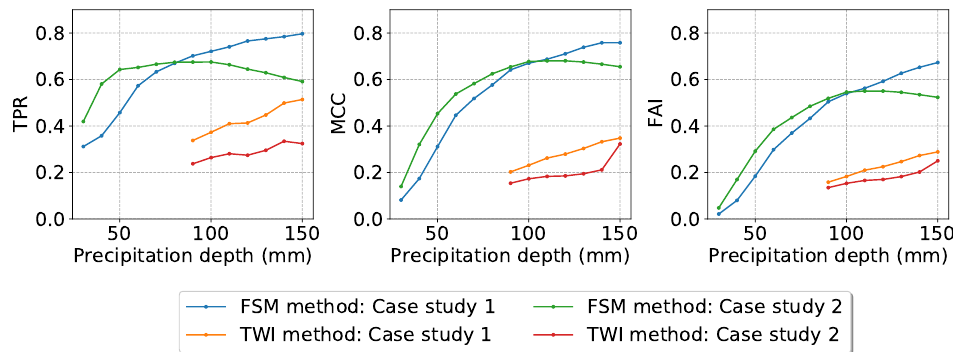
Figure 13. Performance indices for the FSM and TWI methods for different precipitation